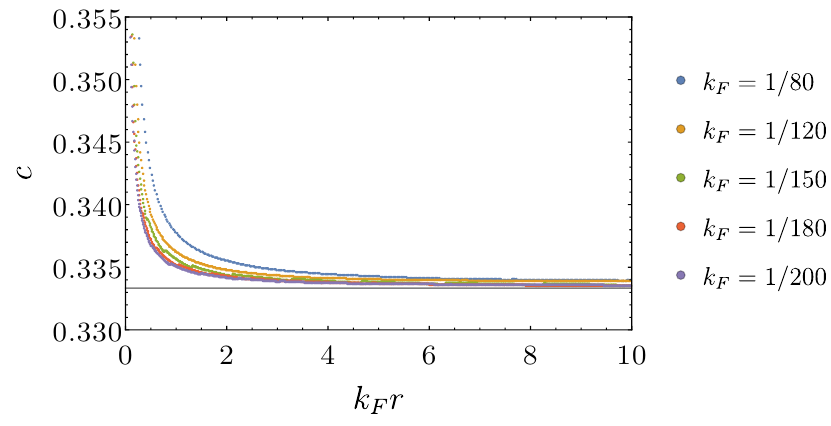
Figure 1 . c ( k F r ) function for a chiral fermion at finite density. For k F → 0 and k F r fixed, the plots tend to 1 , as in a CFT. In this case, the correlation matrices were as large as 4000 × 4000 , 3 since there are two spin degrees of freedom per site. Note the scale values in the c